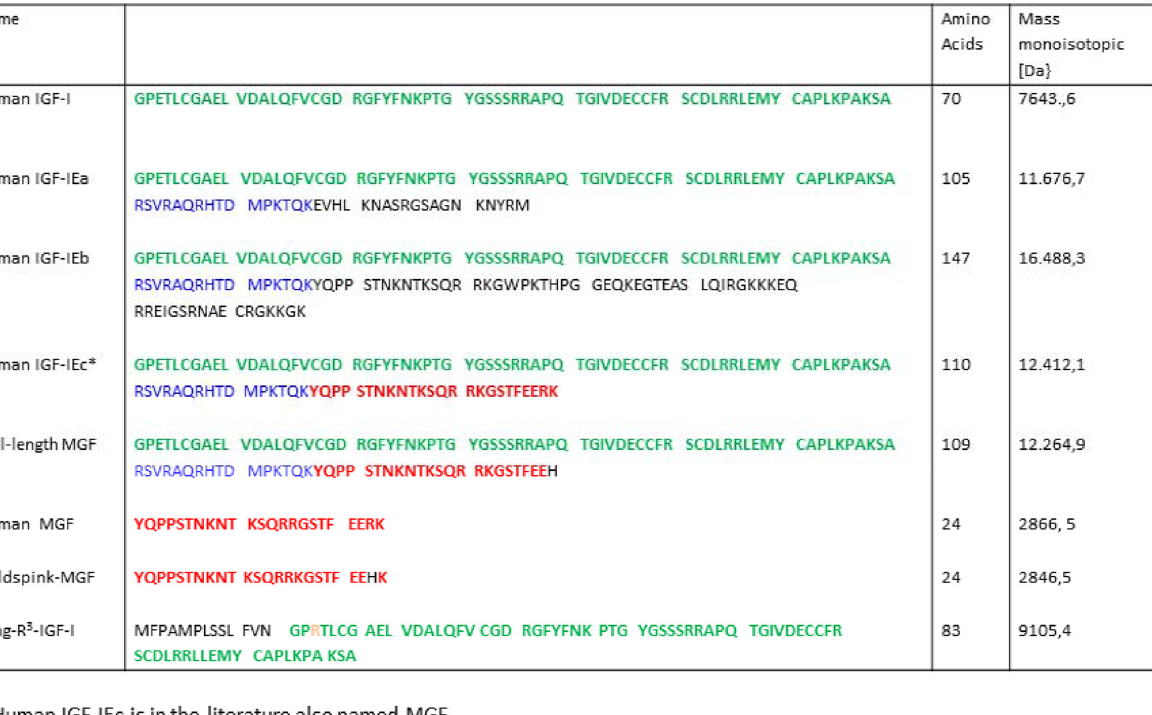
Fig 1. Sequence, number of amino acids and molecular weight of human IGF-I, three human pro-IGF-I isoforms, full-length MGF, Human MGF, Goldspink-MGF and Long R3-IGF-I (modified from Thevis et al. (6)).